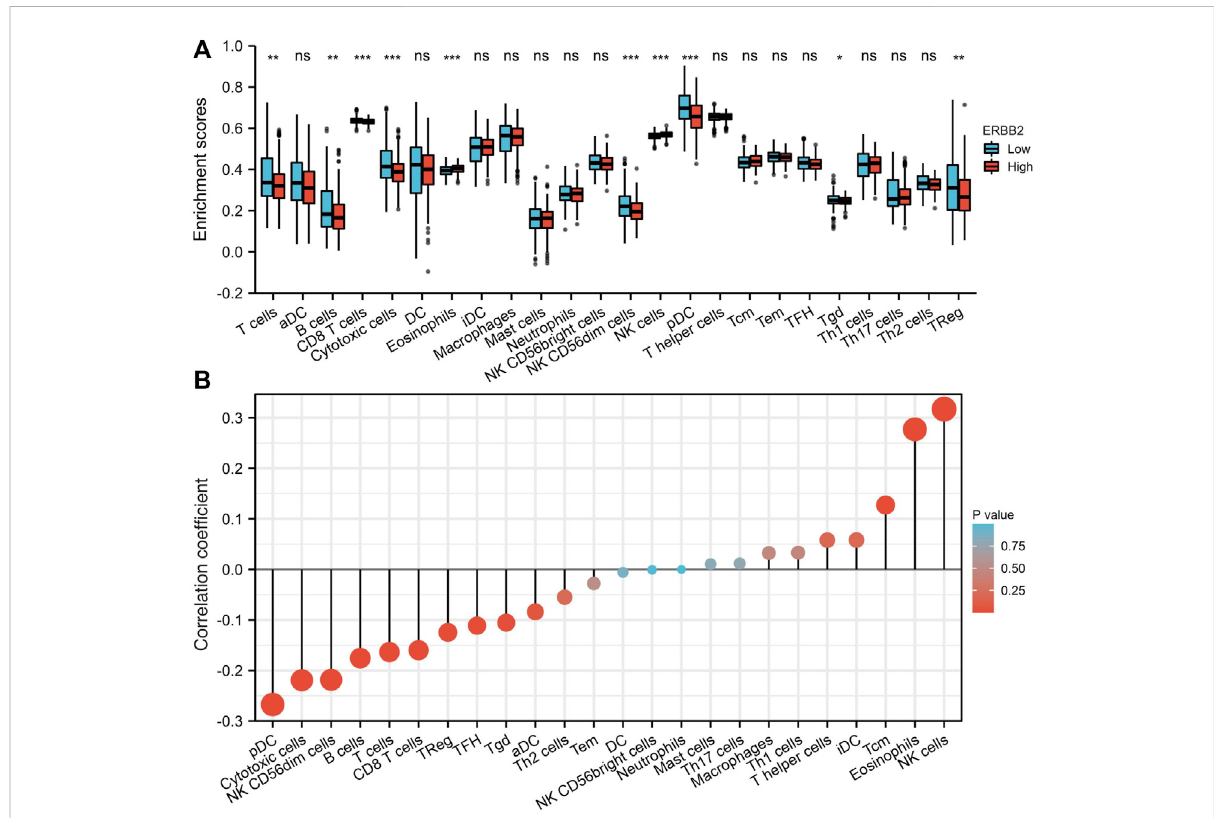
FIGURE 5 Immune cell enrichment scores in thyroid cancer tissues with different ERBB2 expression. (A) The enrichment scores of T cells, B cells, CD8 + T cells, cytotoxic cells, NK CD56dim cells, pDCs, Tgd, and TReg in the ERBB2 high expression group were lower than those in the ERBB2 low expression group. (B) Correlation analysis between the expression of ERBB2 and the enrichment scores of immune in fi ltrating cells in the tumor. ERBB2 expression negatively correlated with the enrichment scores of CD8 + T cell, cytotoxic cell, NK CD56dim cell, pDC, T cell, TFH, Tgd, and TReg. DC, dendritic cell; aDC, activated dendritic cell; pDC, plasmacytoid dendritic cell; iDC, interdigitating dendritic cell; Tcm, central memory Tcell;Tem,effectormemoryTcell;TFH,follicularhelperTcell;Tgd,Tgammadelta, γδ ;Th1,Thelpertype1;Th17,Thelpertype17;Th2,Thelpertype 2; Treg, regulatory T cells; NK, natural killer. * p < 0.05, ** p < 0.01, *** p <